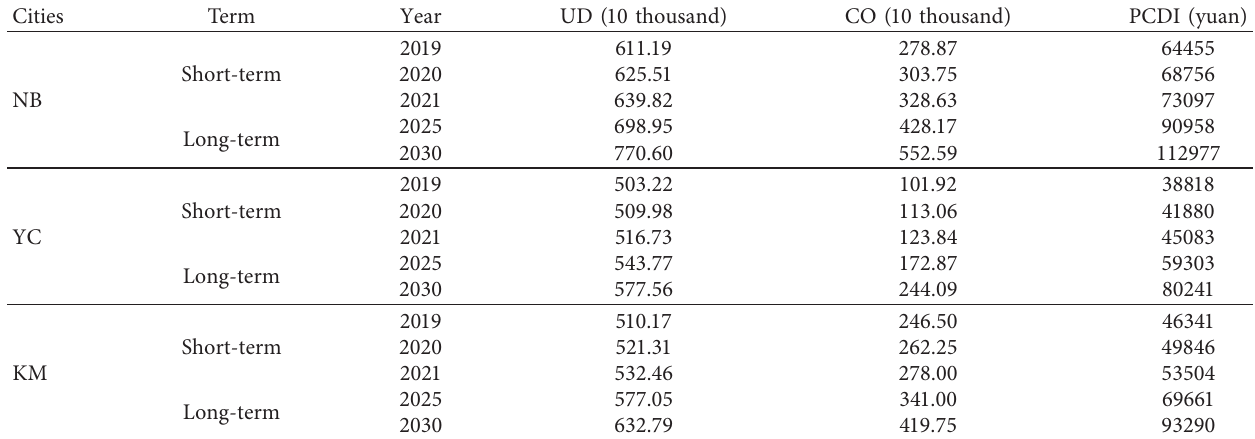
Figure 6: Changes in the three data series for Kunming from 2000 to 2018: (a) changes in the UD historical data, (b) changes in the CO historical data, and (c) changes in the PCDI historical data. Table 7: Time series prediction for 2019–2021